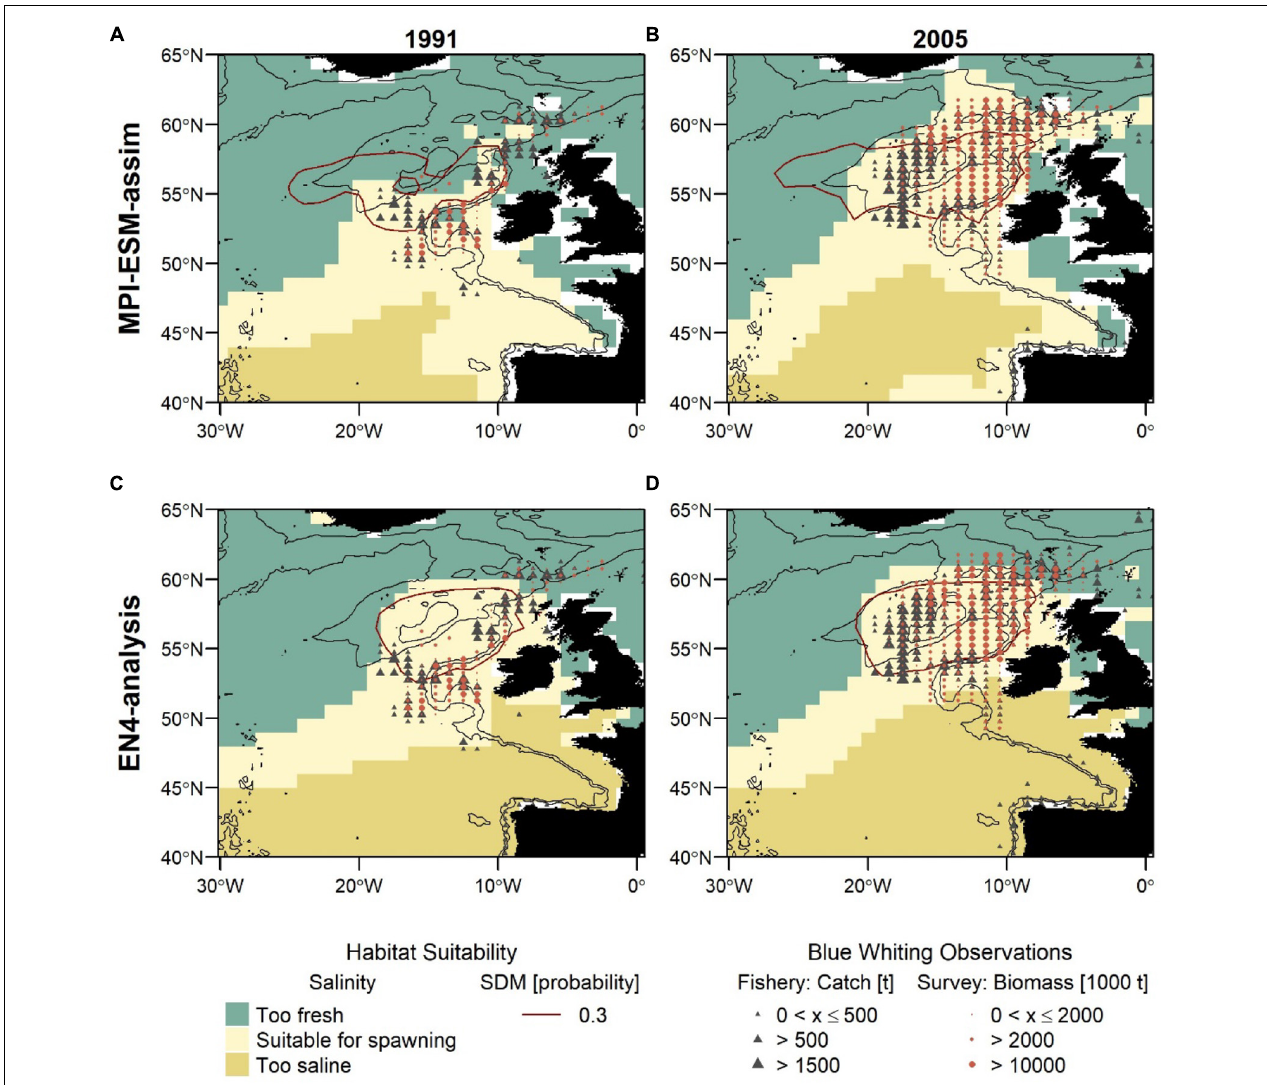
FIGURE 8 | Blue whiting habitat suitability in 1991 (left; A,C ) and 2005 (right; B,D ) for MPI-ESM-assim (top; A,B ) and EN4-analysis (bottom; C,D ) compared to observations of adult blue whiting from scientific surveys (IBWSS; red bullet) and fishery catch data (NEAFC; grey triangle) during March and April. Habitat suitability is shown for both the suitable salinity for spawning (background fill) and the probability of observing blue whiting larvae from SDMs (red contour lines; A,B : SDM_ST MPI ; C,D : SDM_S EN4 ), where 0.3 resembles the threshold for converting the larval-presence probability into presence and absence of suitable habitat. Bathymetry is indicated by 600 and 2,000 m